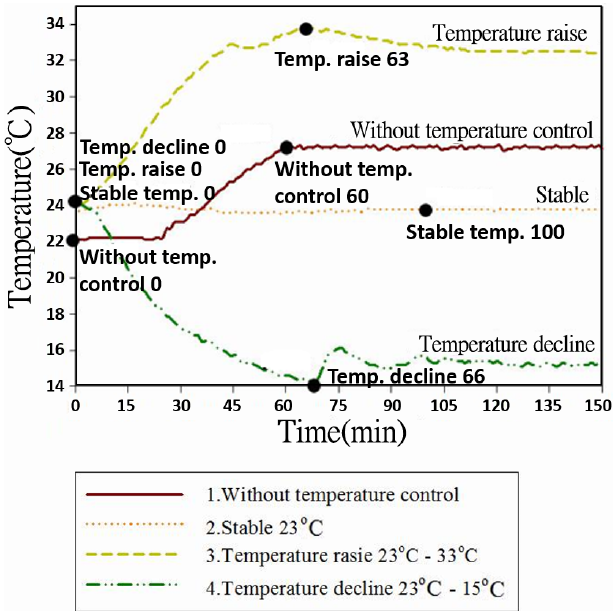
Figure 5. Temperature distributions within the environmental chamber with stable environment, temperature raise, and temperature decline modes.